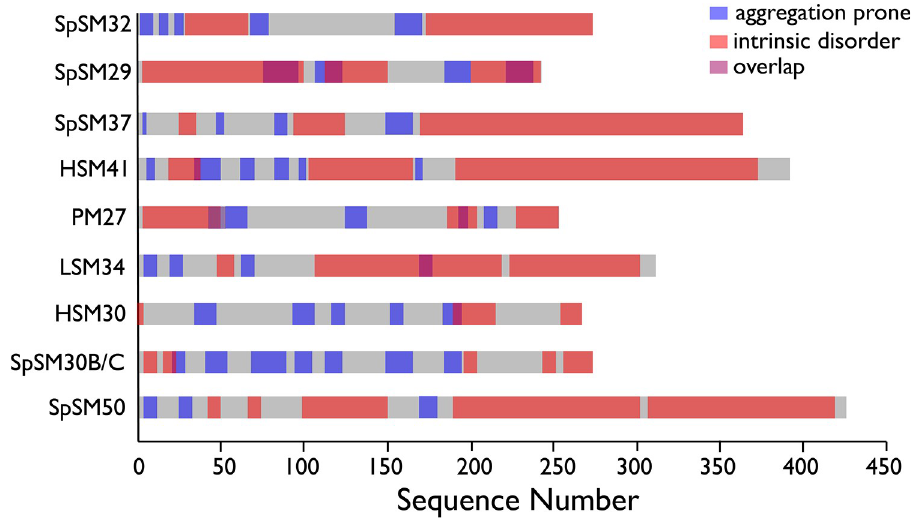
Fig 4. Predicted regions of intrinsic disorder (GLOBPLOT 2.3, DISOPRED, IUP) and aggregation-prone amyloid-like (AGGRESCAN, FOLD_AMYLOID, ZIPPER_DB). Shaded areas (red = intrinsic disorder; blue = amyloid-like cross-beta strand) denote sequence regions predicted as positive by each cohort of algorithms. Grey area denotes regions that do not score as positive for either intrinsic disorder or amyloid-like sequences. Purple color denotes sequence region overlap between aggregation-prone and intrinsic